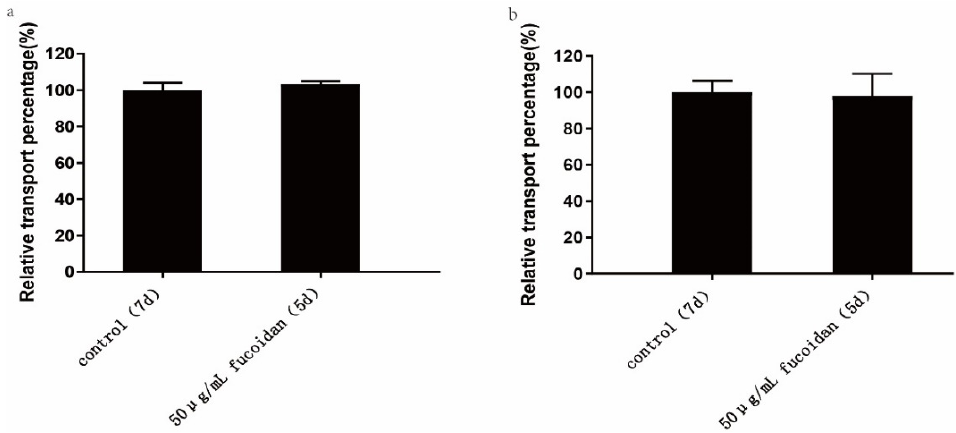
Figure 5. Effect of fucoidan on the absorption of macromolecules. The control group was the 7-day